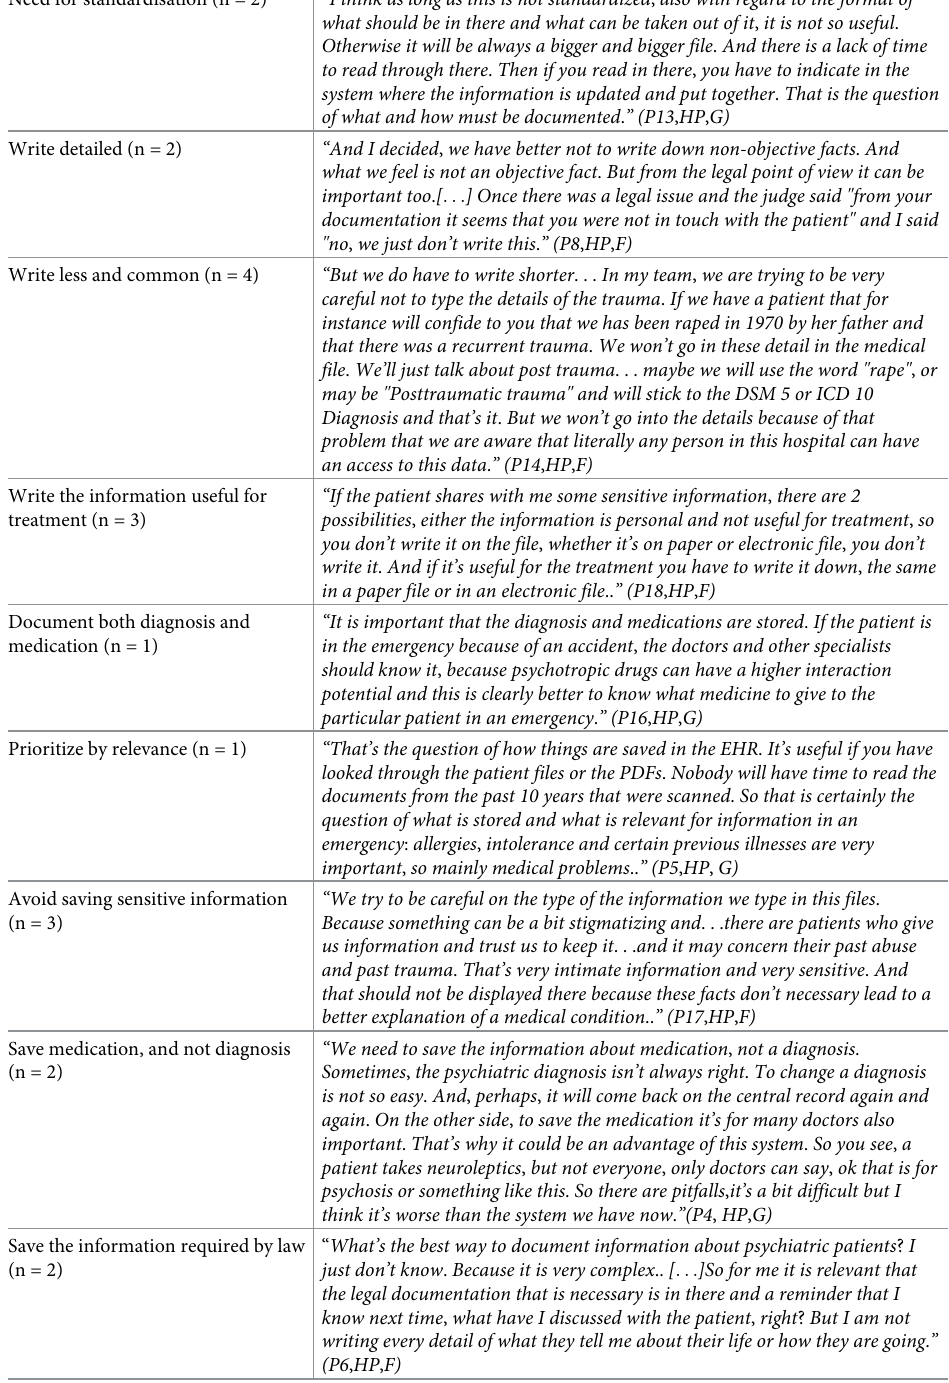
Table 3. Recommendations on how and what to document in